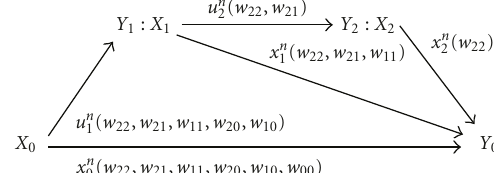
Figure 2: Schematic diagram of sequential partial decoding for two-relay